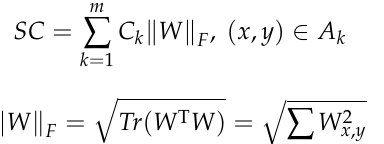
Figure 4. Convolutional kernels and feature maps arranged by spatial continuity from largest to smallest (9 randomly selected): ( a ) Input sample; ( b ) convolutional kernels and the corresponding feature maps.